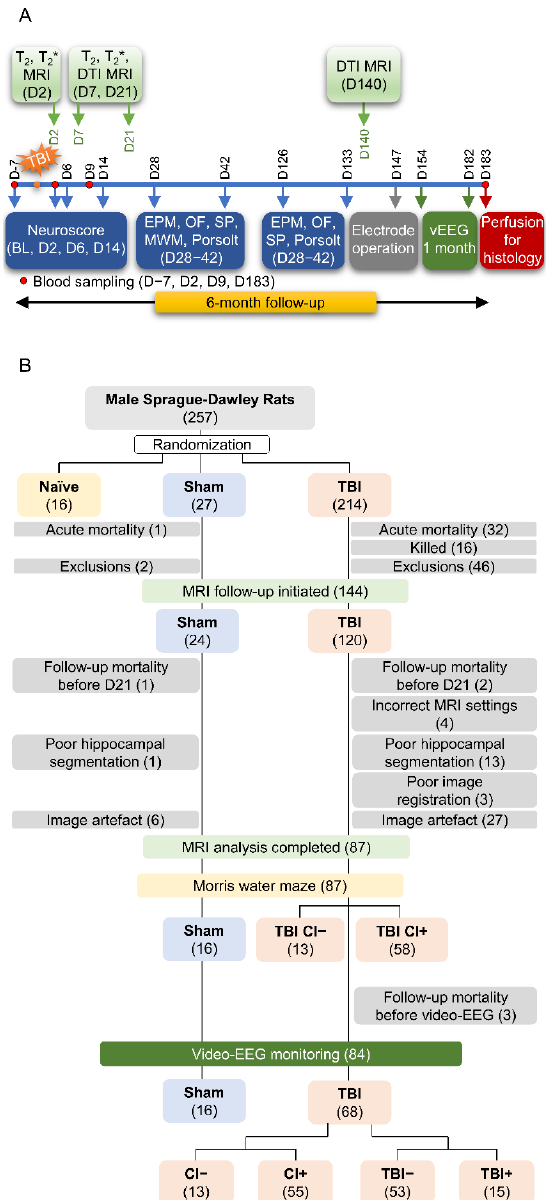
Figure 1. Study flow, number of animals, and exclusions. ( A ) Study design for a 6-month follow-up after experimental traumatic brain injury (TBI). ( B ) Exclusions. A total of 257 male rats were included in the study. The total was divided into 8 subsequent subcohorts over a period of three years as the capacity of the video-EEG monitoring unit was limited to 30 animals. After acute and follow-up mortality and exclusions, 24 sham-operated rats and 120 rats with lateral fluid-percussion-induced TBI were included in the MRI follow-up. The severity of cognitive impairment was assessed using the Morris water maze test (MWM) on day (D) 35-D39. The development of epilepsy was determined by undertaking continuous 30-d video-EEG monitoring on the 6th post-injury month [22]. The reasons for MRI-related exclusions included missing data (follow-up mortality), incorrect MRI settings, poor hippocampal segmentation, poor image registration, and presence of image artefacts. Thus, data from 16 sham and 68 TBI animals were included in the final analysis. Of the TBI animals, 55 displayed a cognitive impairment and 15 had post-traumatic epilepsy. Abbreviations: CI − , rats without cognitive impairment; CI+, rats with cognitive impairment; T 2 , T 2 relaxation time; T 2 *, T 2 * relaxation time; DTI, diffusion tensor imaging; EPM, elevated plus-maze; MRI, magnetic resonance imaging; OF, open-field; SP, sucrose preference; TBI − , rats without epilepsy; TBI+, rats with